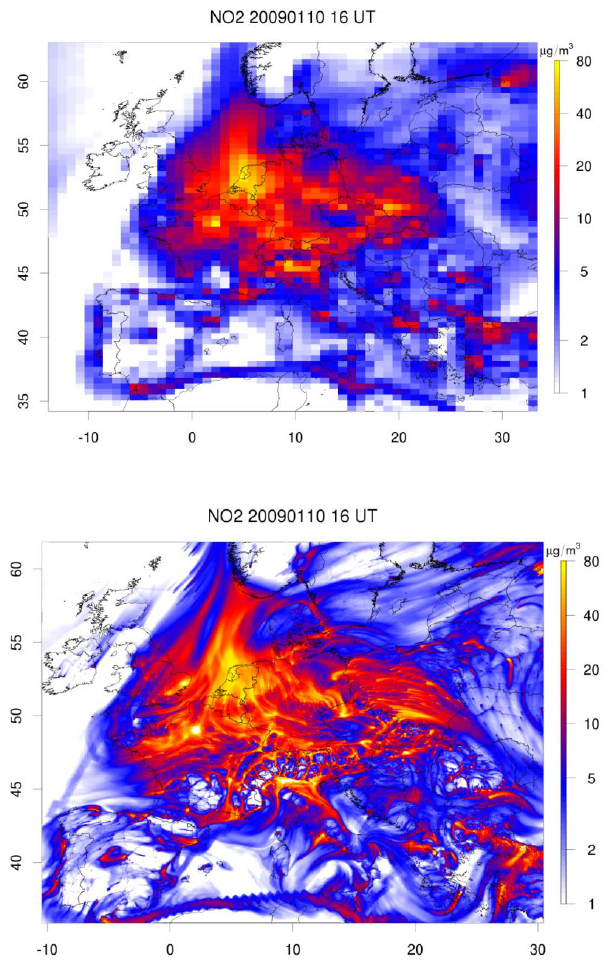
Fig. 2. Map of emissions of fine primary particulate matter (PPM) Figure 2 : Map of NO 2 (µg/m 3 ) on January 10, 2009 at 16UTC in the 57km (top) and 2km (bottom) resolution CHIMERE 1 emissions (in moleculecm − 2 s − 1 ) over the day of 10 January 2009 in the 57km (top) and 2km (bottom) resolution simulations. 2